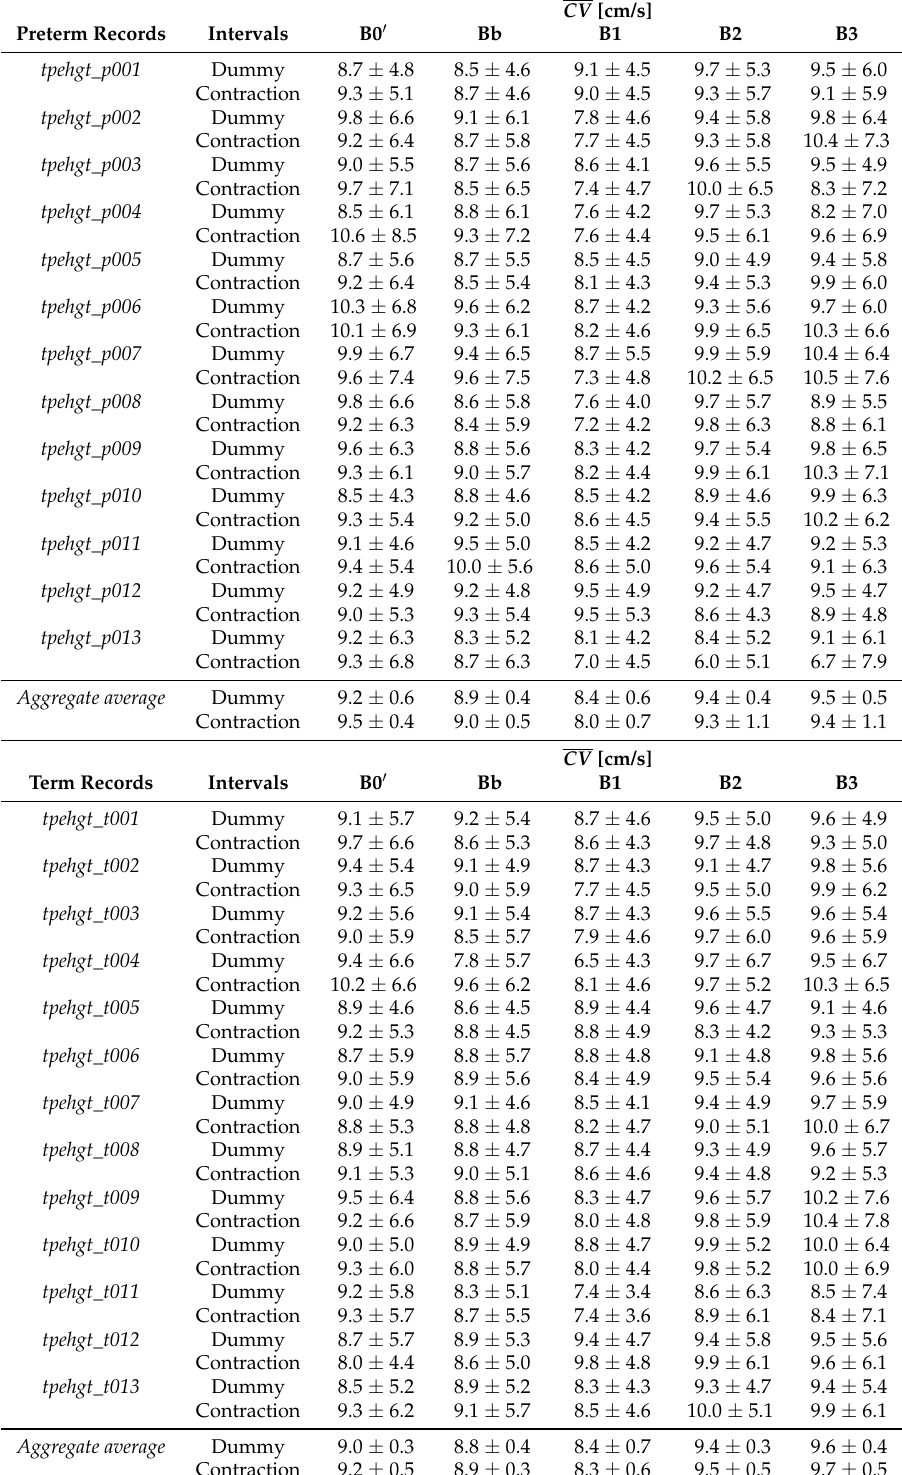
Table A1. Average conduction velocity amplitudes, CV , as estimated from preterm and term dummy and contraction intervals of the EHG records of the TPEHGT